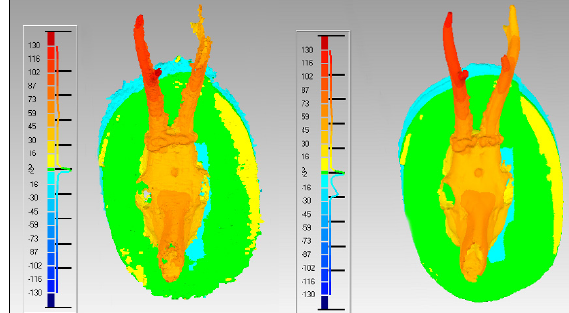
Figure 5. DEM comparison of the DAVID (left) and the ARTEC MH